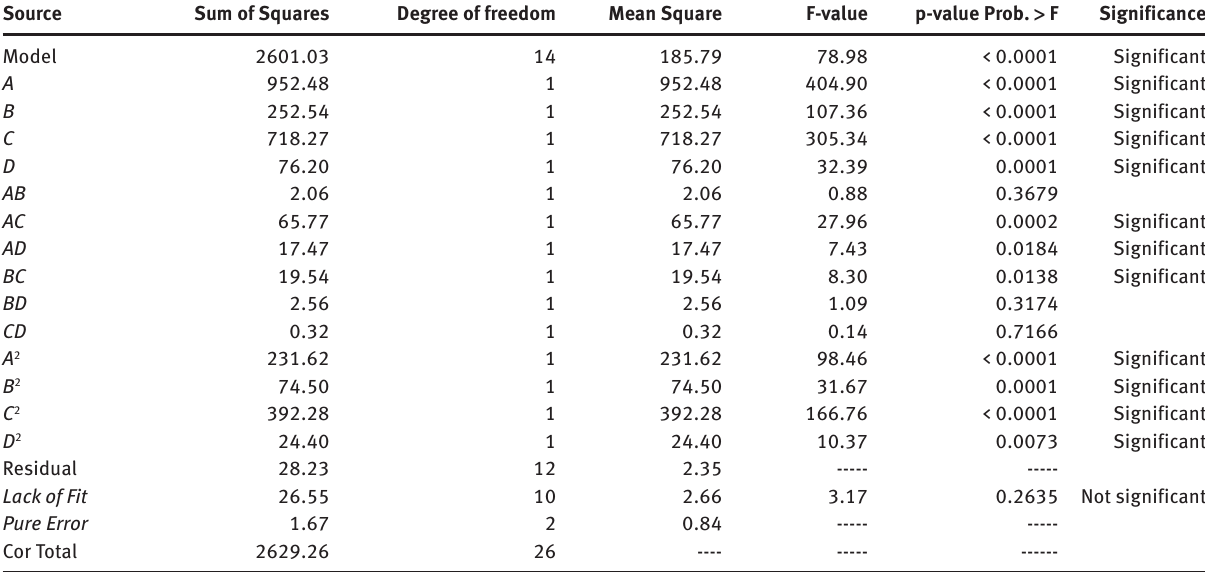
Table 5: Regression analysis of BBD criterion data for leaching of manganese.